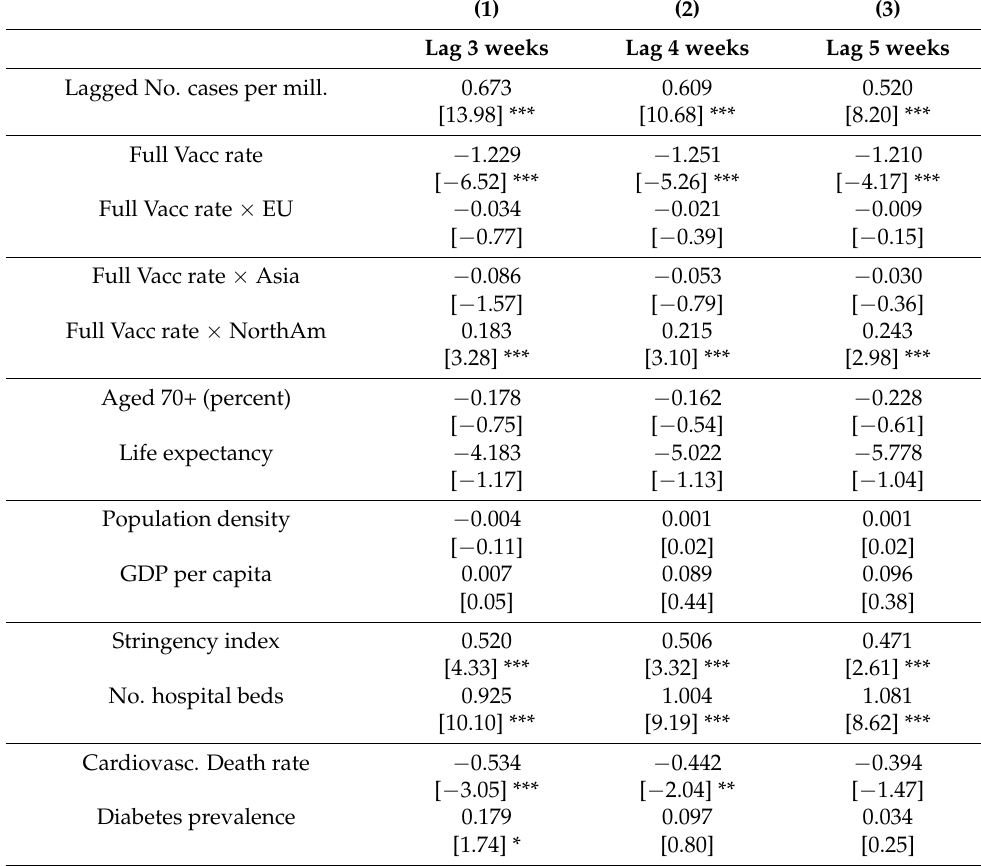
Table A5. Impact of vaccination rate on number of new ICU